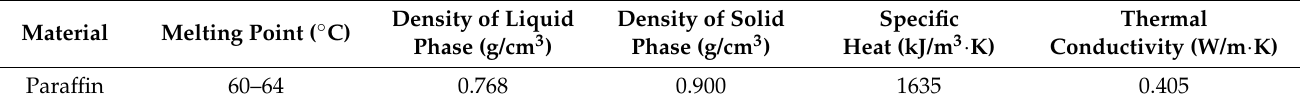
Table 1. Thermophysical properties of paraffin.